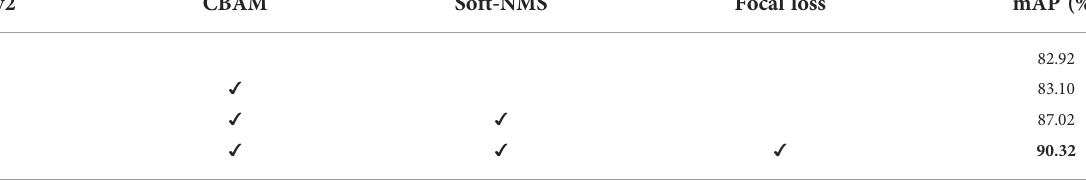
TABLE 3 Ablation